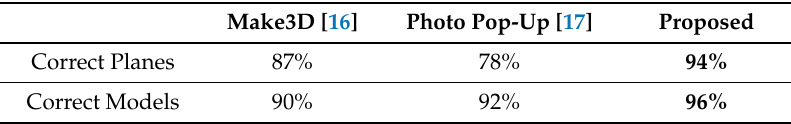
Table 6. Comparisons of scene